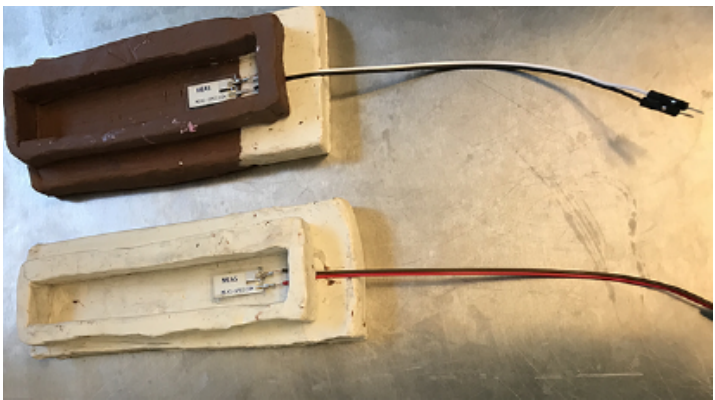
Figure 10. Two implemented clay molds for rubber plates.